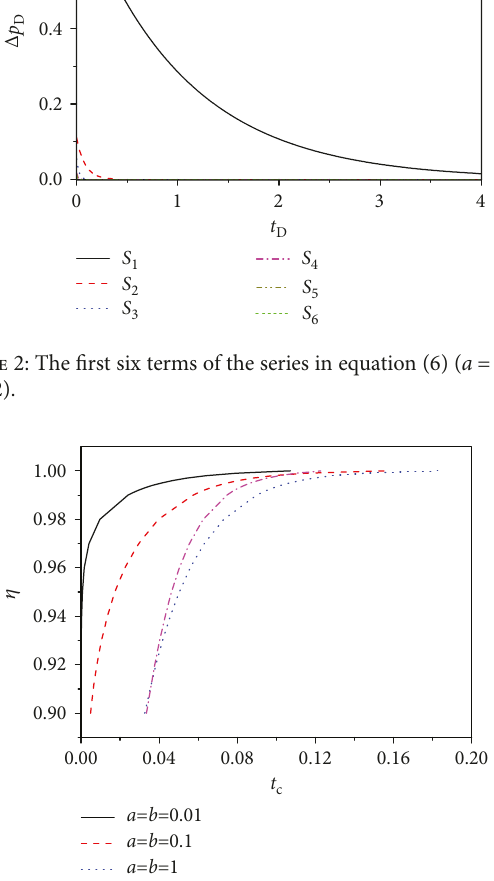
Figure 3: The evolution of critical time t chamber